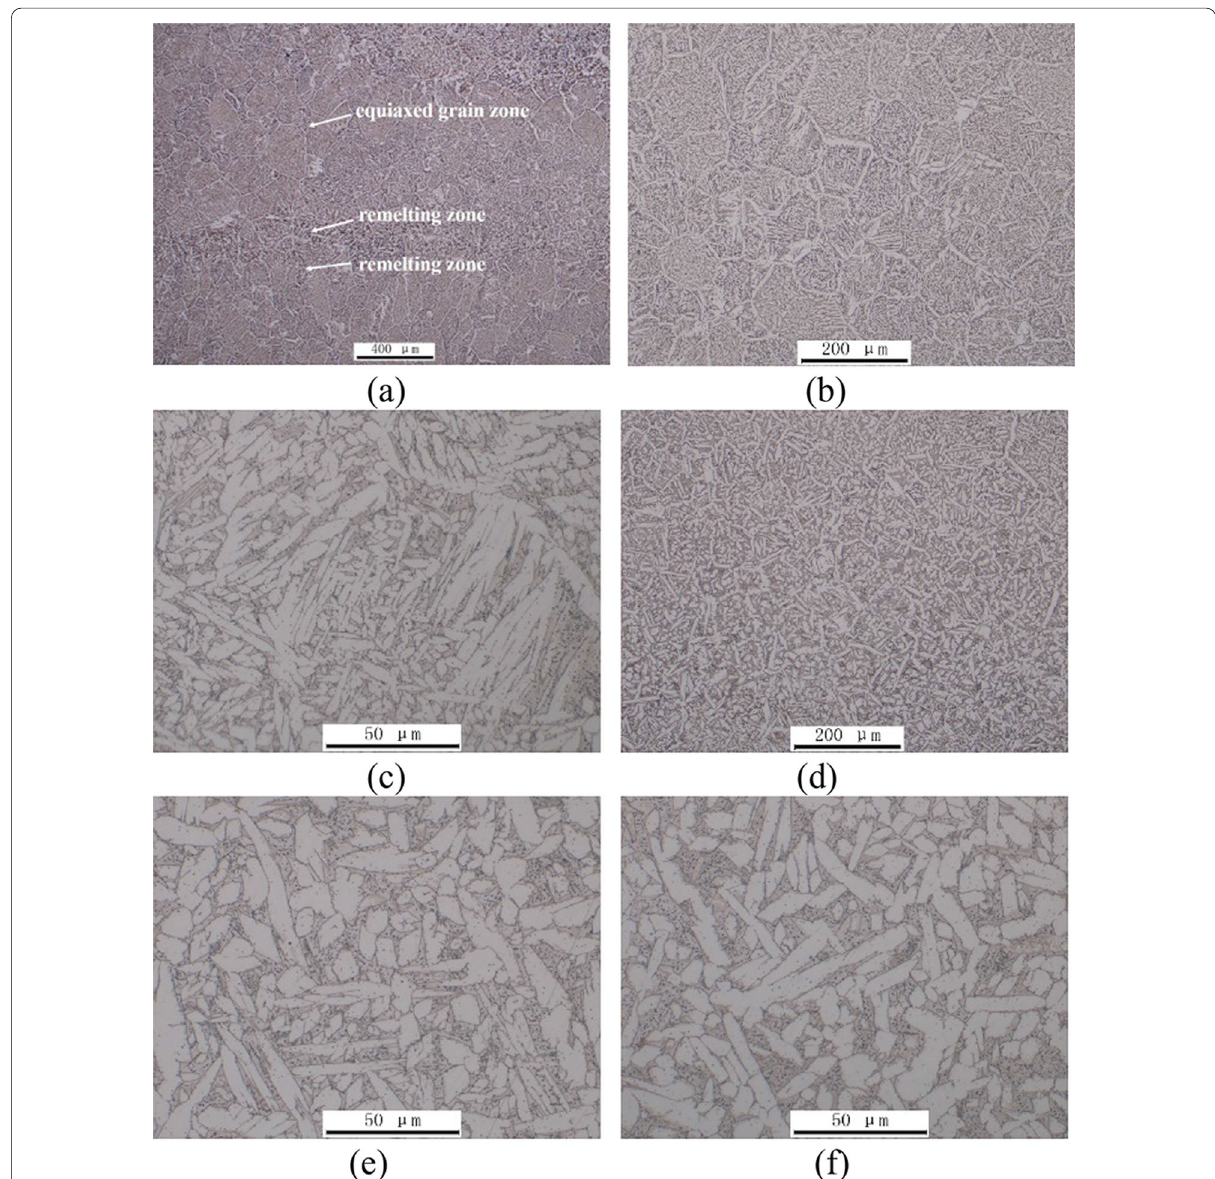
Figure 4 Microstructures of the specimens: a 50 zone 500 , and f heat-affected zone 500 ×